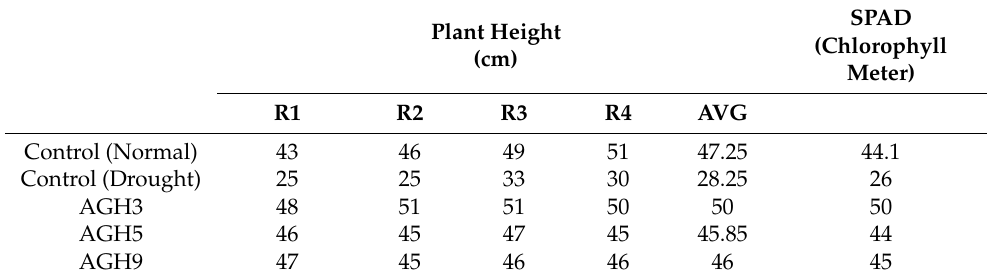
Table 4. Role of selected isolates on plant height and total chlorophyll contents of the S. lycopersicum